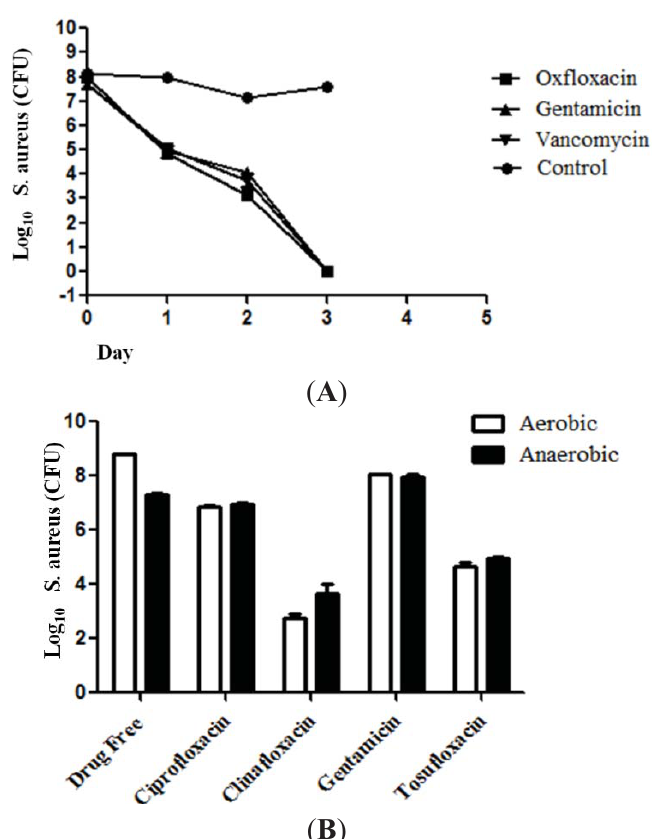
Figure 3. The effect of tosufloxacin against S. aureus persisters that survived from different cidal antibiotic treatments and comparison of the activity of antibiotics in aerobic and anaerobic environments. ( A ) S. aureus persisters enriched by ofloxacin, gentamycin or vancomycin were similarly killed by tosufloxacin (50 μM). The S. aureus stationary phase culture was treated with ofloxacin (10 μg/mL), gentamycin (10 μg/ mL) or vancomycin (10 μg/mL) for four hours to enrich persisters. Then, the surviving persisters from the treatment were subjected to drug exposure with tosufloxacin (50 μM); ( B ) The activities of antibiotics were comparable in aerobic and anaerobic environments. The S. aureus stationary phase culture was exposed to 20 μM of the respective drugs and incubated for 3 days at 37 °C (aerobically and anaerobically) when the CFU was